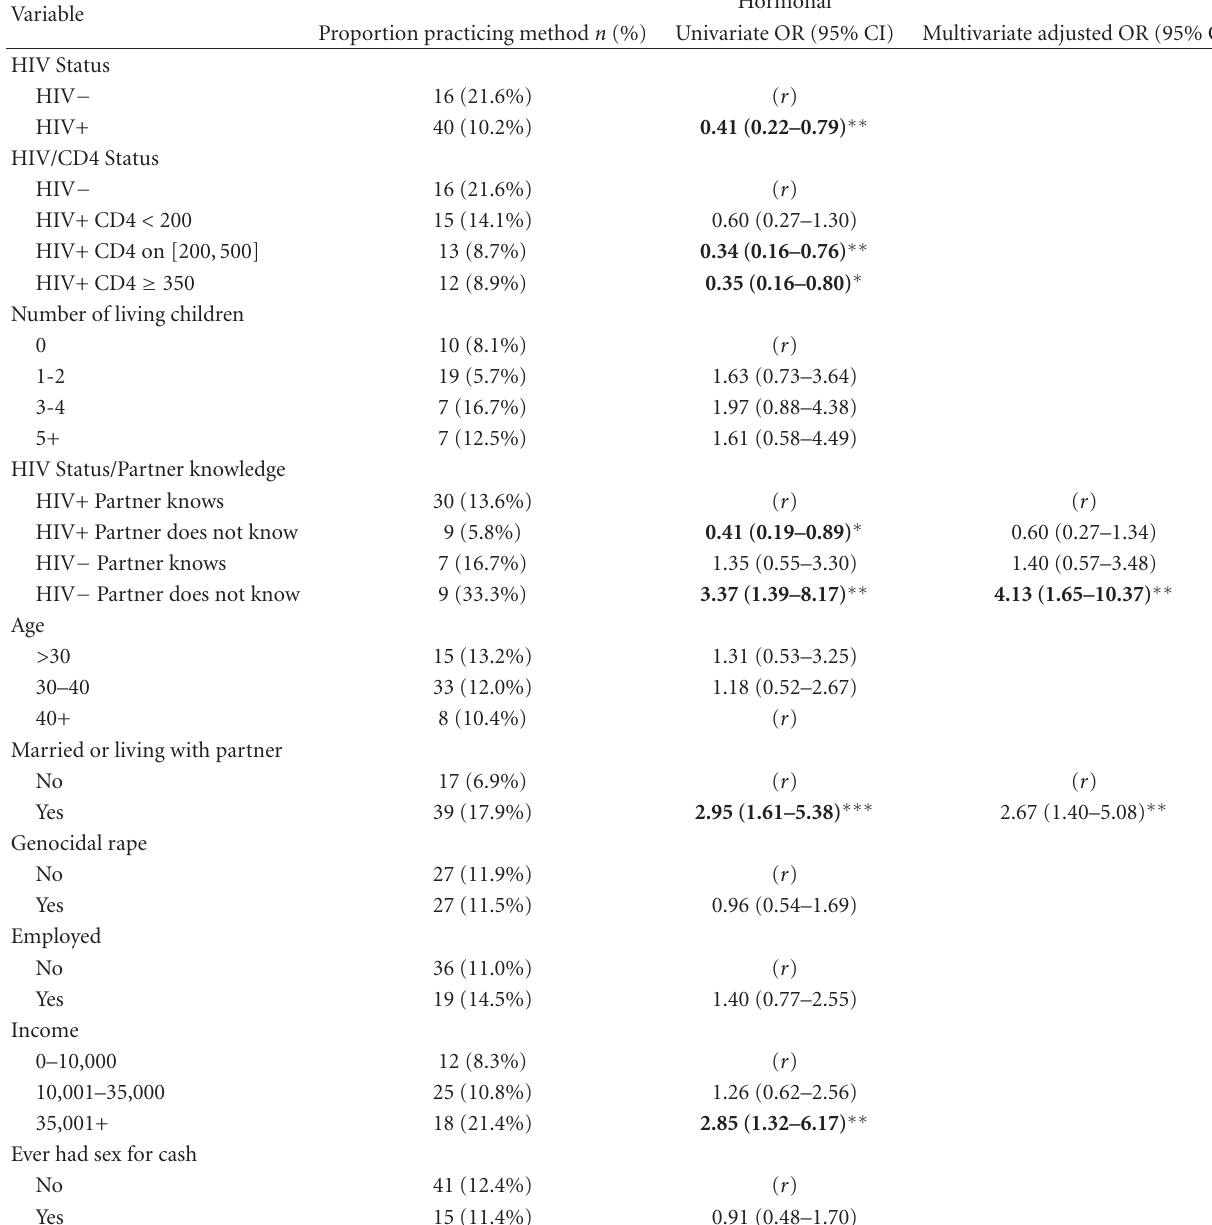
Table 4: Univariate and multivariate analysis of demographic and clinical characteristics associated with hormonal contraceptive use.